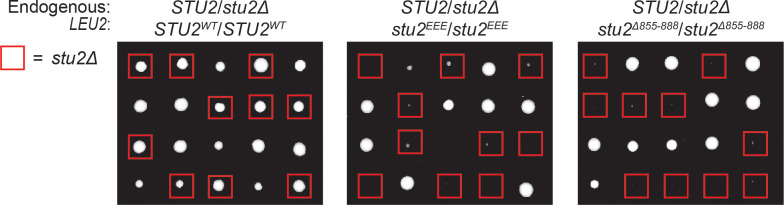
Heterozygous diploid dissection of different stu2 mutant alleles.Diploid cells heterozygous for STU2/stu2∆::HIS3 at the endogenous STU2 locus and homozygous for different STU2 alleles integrated at the LEU2 locus (STU2WT/STU2WT, M1718; stu2EEE/stu2EEE, M1714; stu2∆855-888/ stu2∆855-888, M1716) were sporulated and dissected on YPD plates. Spores scored positively for HIS3 are boxed in red. Spores harboring both deletion of endogenous STU2 and either stu2EEE or stu2∆855-888 have a viability defect. The stu2EEE strain shows a dominant meiotic phenotype in this assay as well, possibly resulting from aberrant meiotic chromosome segregation in STU2/stu2∆:HIS3 stu2EEE/stu2EEE diploid cells.